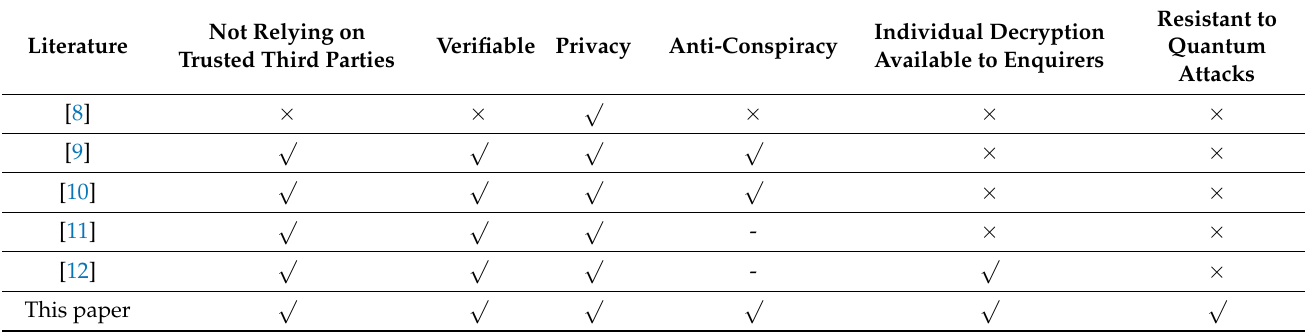
Table 1. Performance comparison of this paper with other SMPC